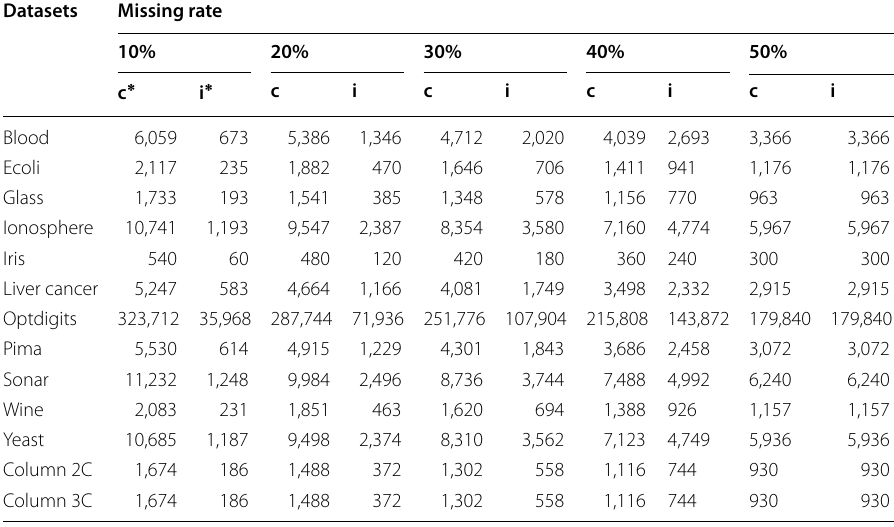
∗ c complete data, i =